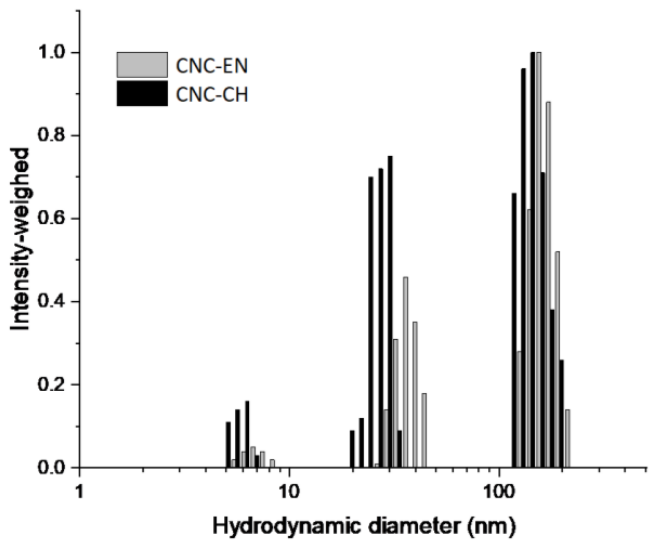
Figure 3. Hydrodynamic size distributions of tomato CNC-CH and CNC-EN. Measurements were performed at r.t. in water. The populations below 10 nm were ascribed to process residual